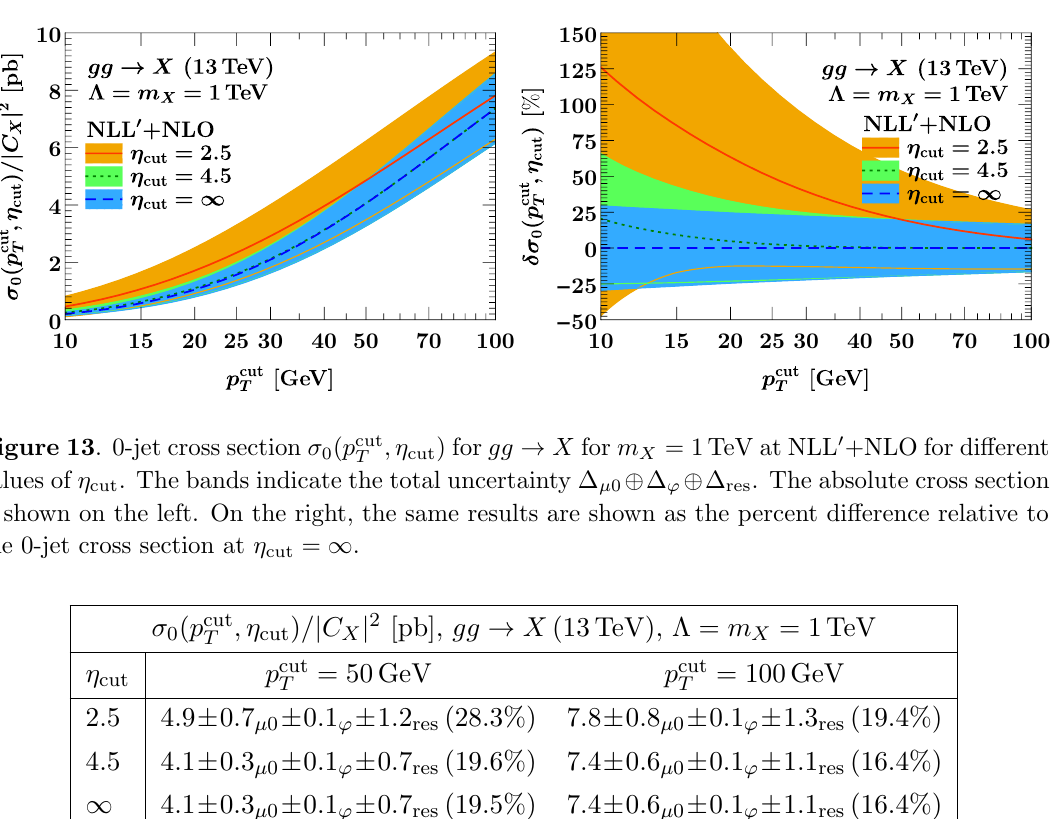
Table 2 . 0-jet cross section for gg and (cid:17) cut with a breakdown of the